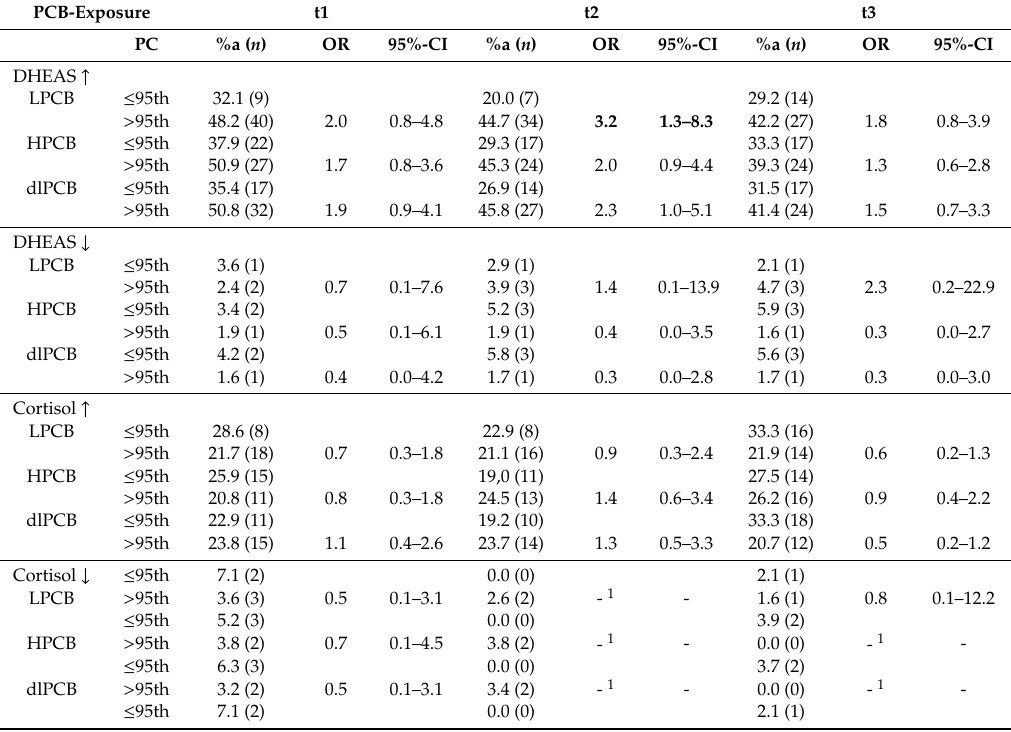
Risk analyses of abnormal DHEAS and cortisol concentration for higher- and background-burdened participants ( N =